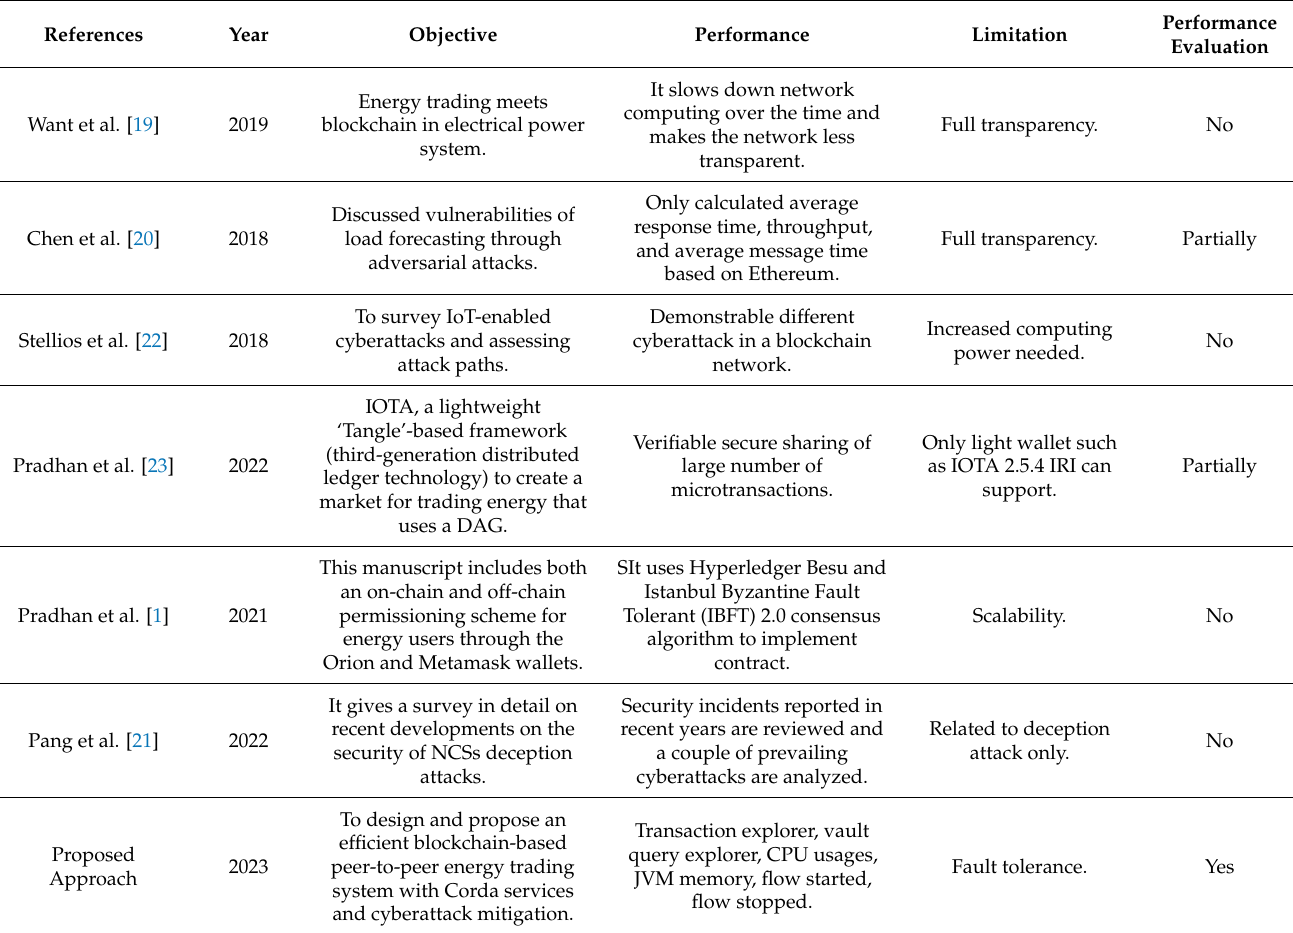
Table 1. Related work on blockchain-based peer-to-peer energy trading